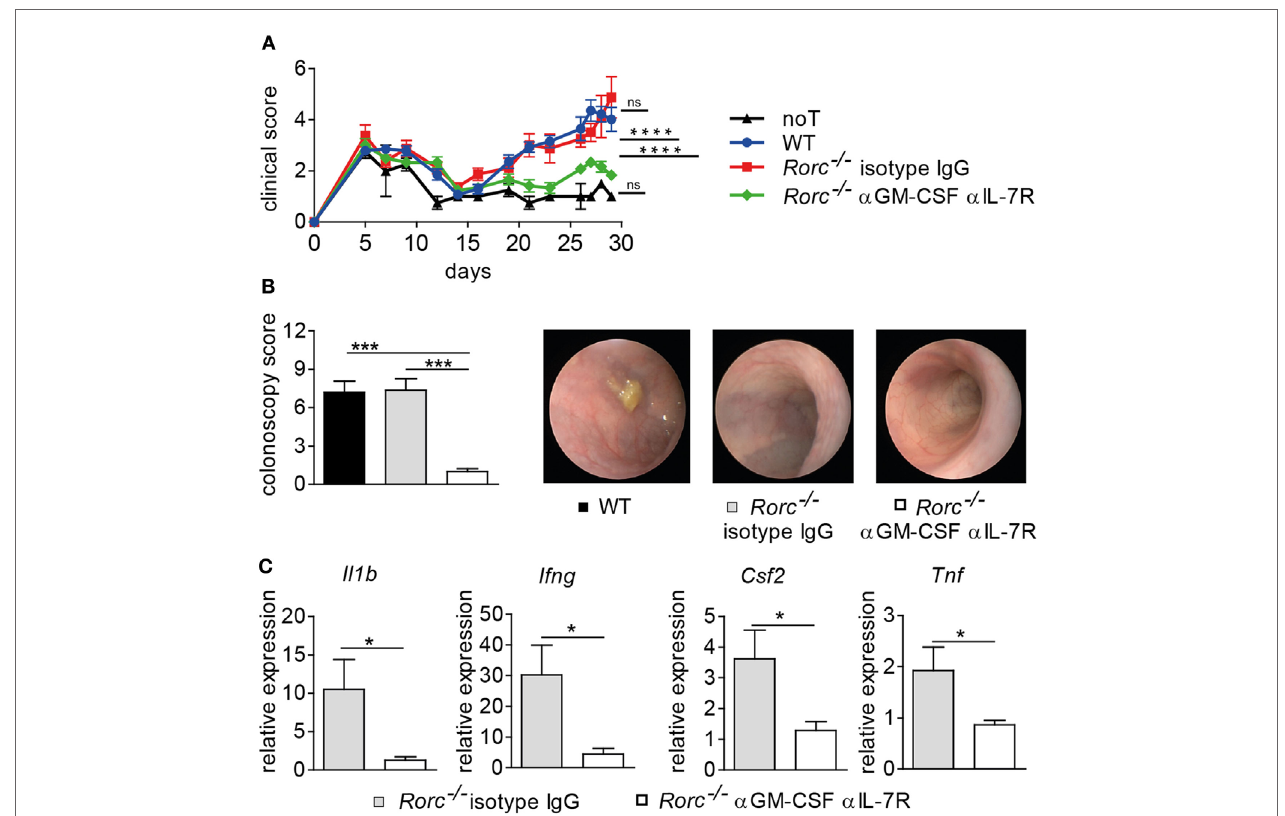
FigUre 6 | Blockade of interleukin-7 receptor (IL-7R) and granulocyte-macrophage colony-stimulating factor (GM-CSF) mitigates graft-versus-host disease (GvHD)- associated colitis elicited by retinoic acid-related orphan receptor gamma t-deficient donor T cells. Irradiated BALB/c mice received T cell depleted bone marrow alone [no T cells (noT), n = 2] or were subsequently injected with allogeneic pan T cells of wild-type (WT) ( n = 6) or Rorc − / − mice. One group of Rorc − / − T cell receiving mice was treated 3 × /week with anti-GM-CSF antibody ( α GM-CSF) throughout the experiment together with anti-IL7R ( α IL-7R) until day 15 ( n = 5) while another group was treated with isotype IgG antibody ( n = 4) alone. Data are shown from one representative experiment. (a) Mice were evaluated 3 × /week for the presence of clinical symptoms of GvHD and its severity was accordingly scored. Data were analyzed by two-way ANOVA testing followed by Bonferroni’s multiple comparisons posttest. **** p < 0.0001 was considered significant, whereas p > 0.05 indicates no significance (ns). (B) At day 29, colitis activity was assessed by colonoscopy and representative endoscopic images are shown. Data were analyzed by two-way ANOVA testing followed by Bonferroni’s multiple comparisons posttest. *** p < 0.001 was considered significant. Mice were sacrificed day 30. (c) Transcript levels of Tnf , Il1b , Ifng , and Csf2 in colonic tissue of Rorc − / − T cell receiving mice treated with anti- GM-CSF together with anti-IL-7R or with isotype IgG antibody alone were analyzed by quantitative real-time PCR. Gene expression data were analyzed by Student’s t -test. * p < 0.05 was considered significant. All data are shown as mean ±